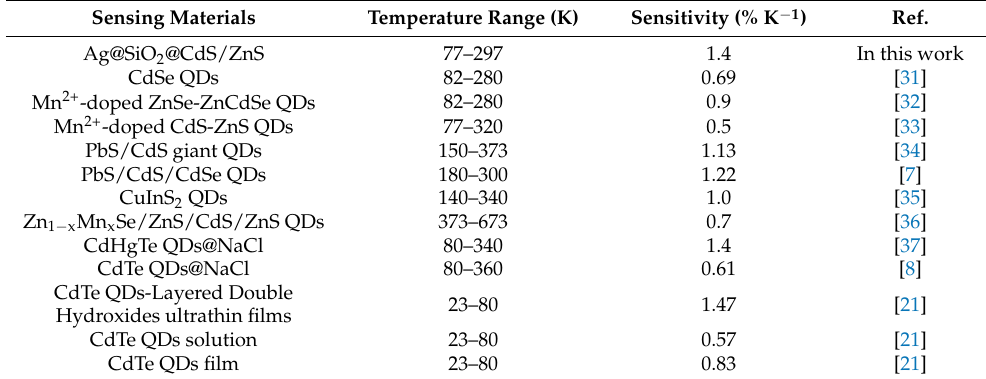
Table 2. Comparison of the previous reported temperature sensors based on semiconductor